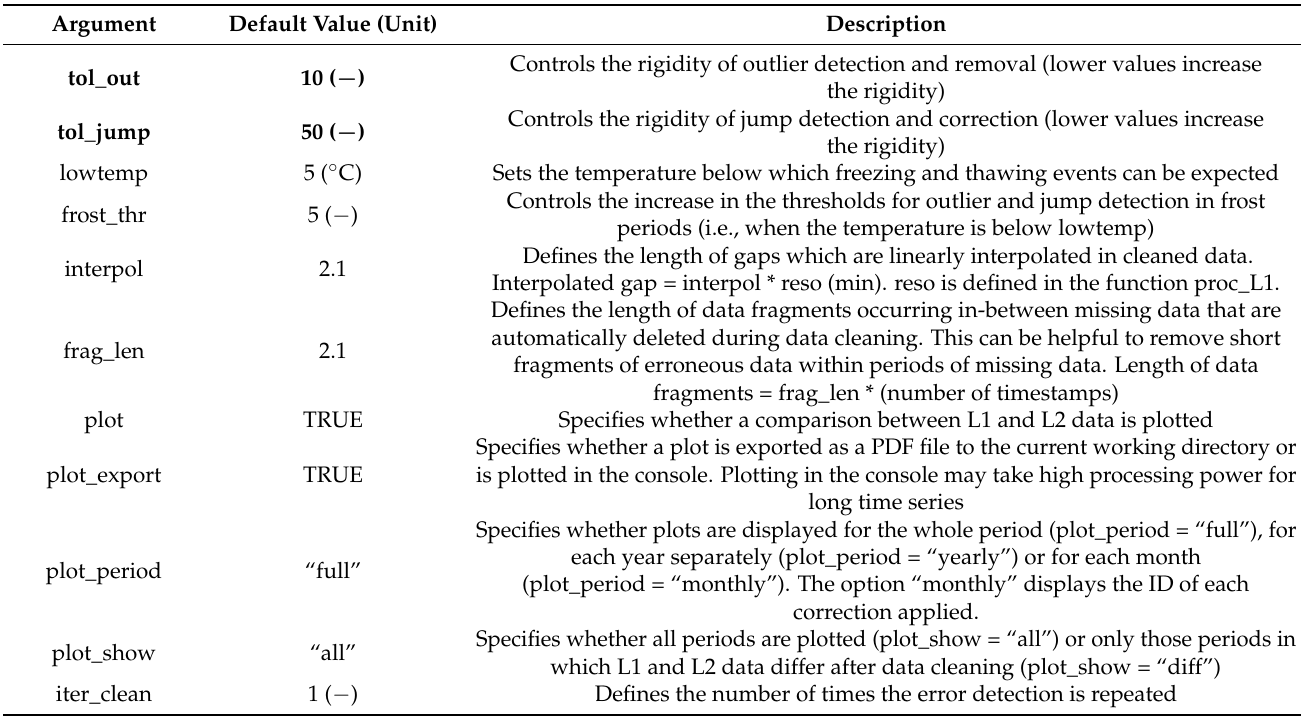
Table 2. Customised parameters of the function proc_dendro_L2. The first two parameters (in bold) are most important to optimise error